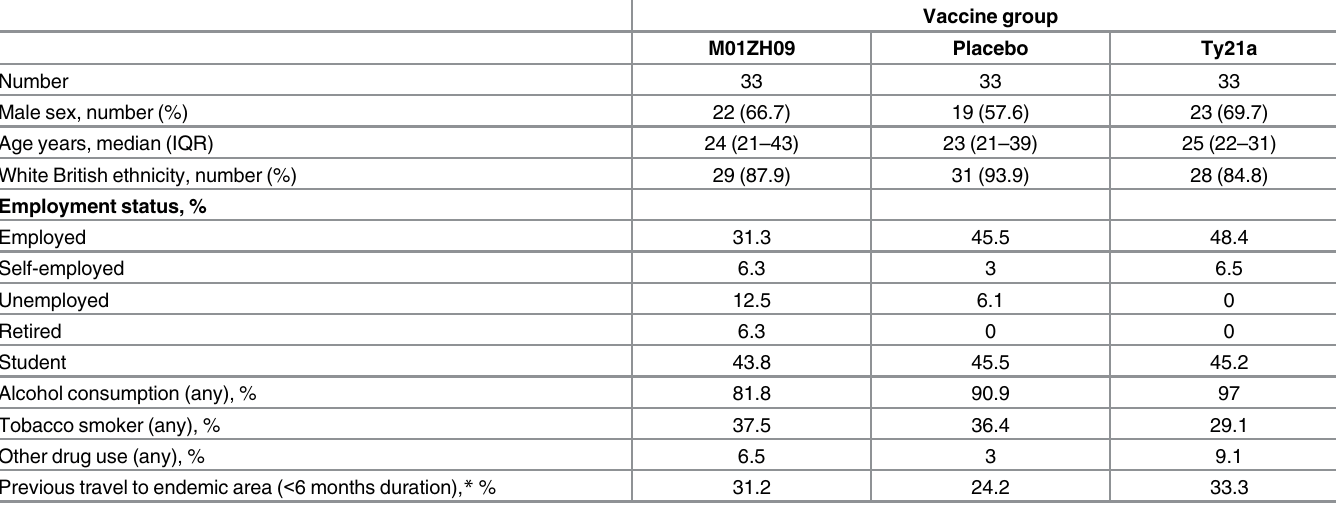
Table 1. Participant characteristics by enrolled vaccine